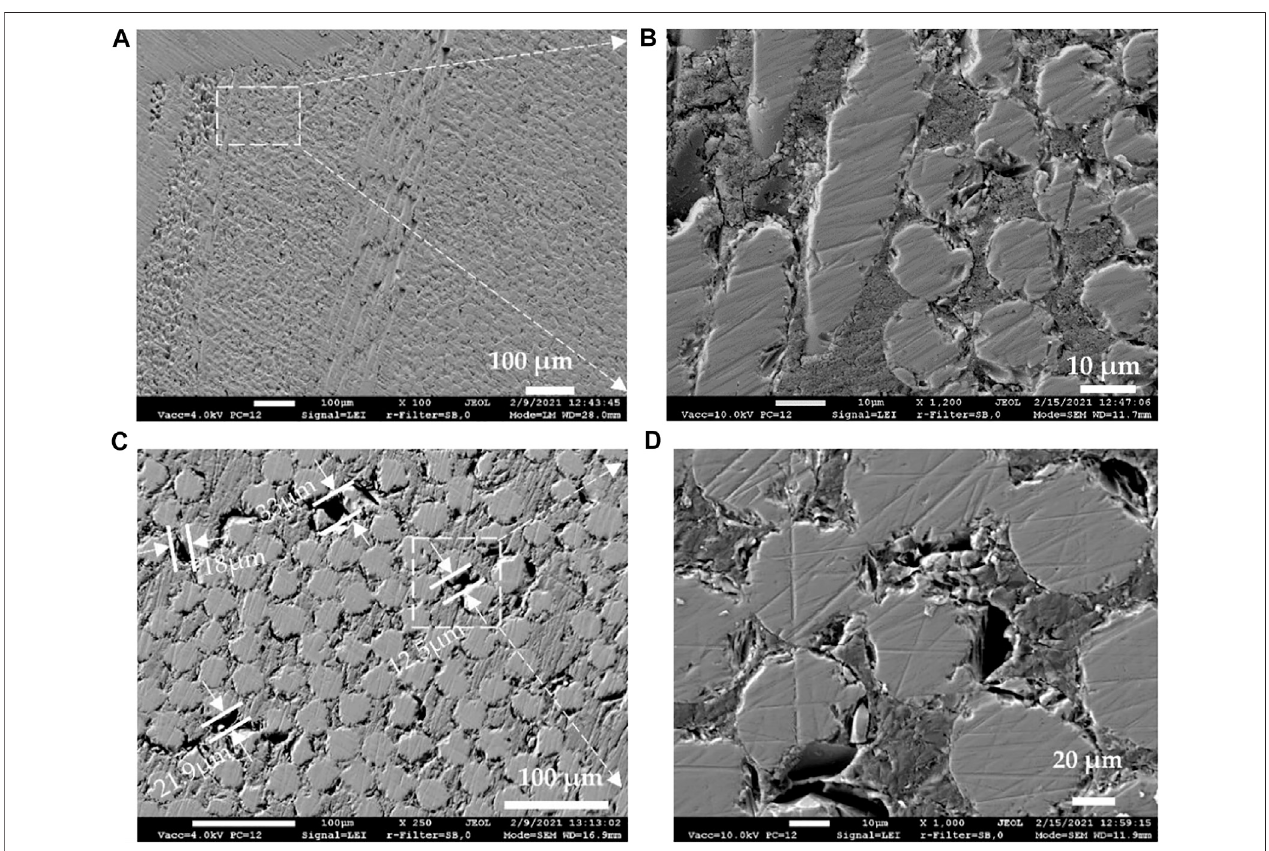
FIGURE 6 | SEM images of the corner zones: (A , B) F IBERLINE pro fi le; (C , D) U GIRA sample. Note: the rectangles localize the zoomed view place of the images (B , D) .